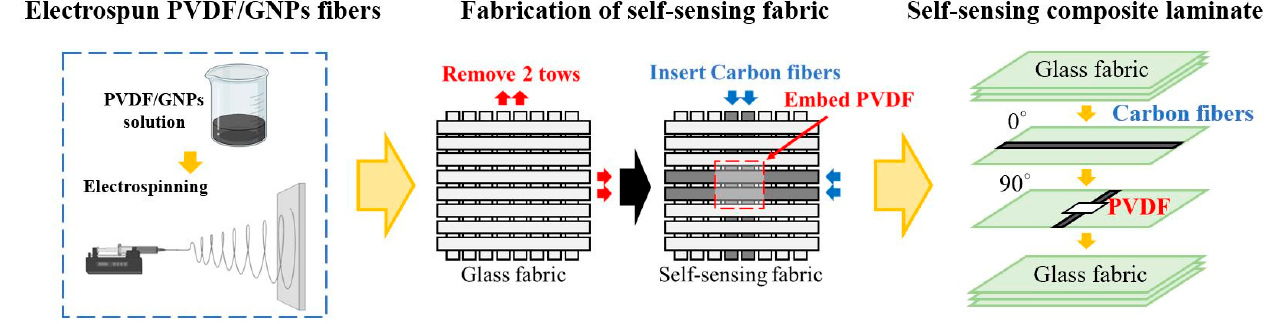
Figure 1. Schematic of fabricating the self-sensing composite